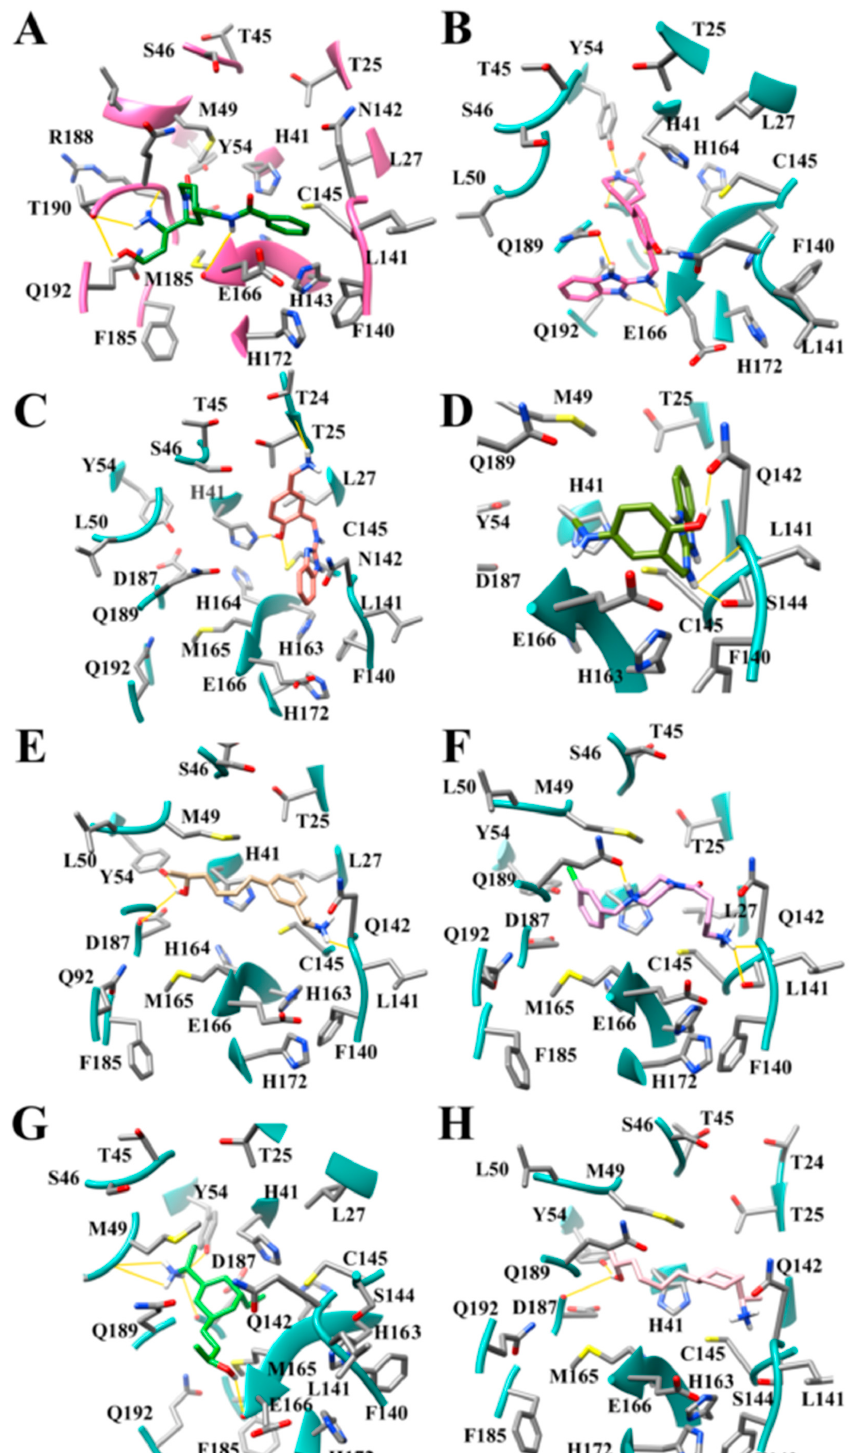
Figure 14. Modes of binding for compounds demonstrating key hydrogen bonding hotspots in the active site of SARS-CoV-2 M pro ( A ) JN16 (green) interacting in the S4 hydrogen bonding hotspot; ( B ) KF08 (pink) hydrogen bonding in hotspots located in the S2 subsite and the active site core; ( C ) KF03 (salmon) hydrogen bonding in hotspots located in the S1 (cid:48) subsite and the active site core; ( D ) KF04 (olive) hydrogen bonding S1 subsite hotspots; ( E ) EW14 (tan) hydrogen bonding in the hotspots located in the S2 subsite and the S1; ( F ) HS06 (purple) hydrogen bonding hotspots located in the S1 subsite and the active site core; ( G ) AMM2 (lime) shown hydrogen bonding in S2 subsite hotspot and the active site core; and ( H ) AMM4 compounds designed for aliphatic substituent dataset in SARS-CoV-2 M pro receptor. Hydrogen bonds are indicated by solid yellow